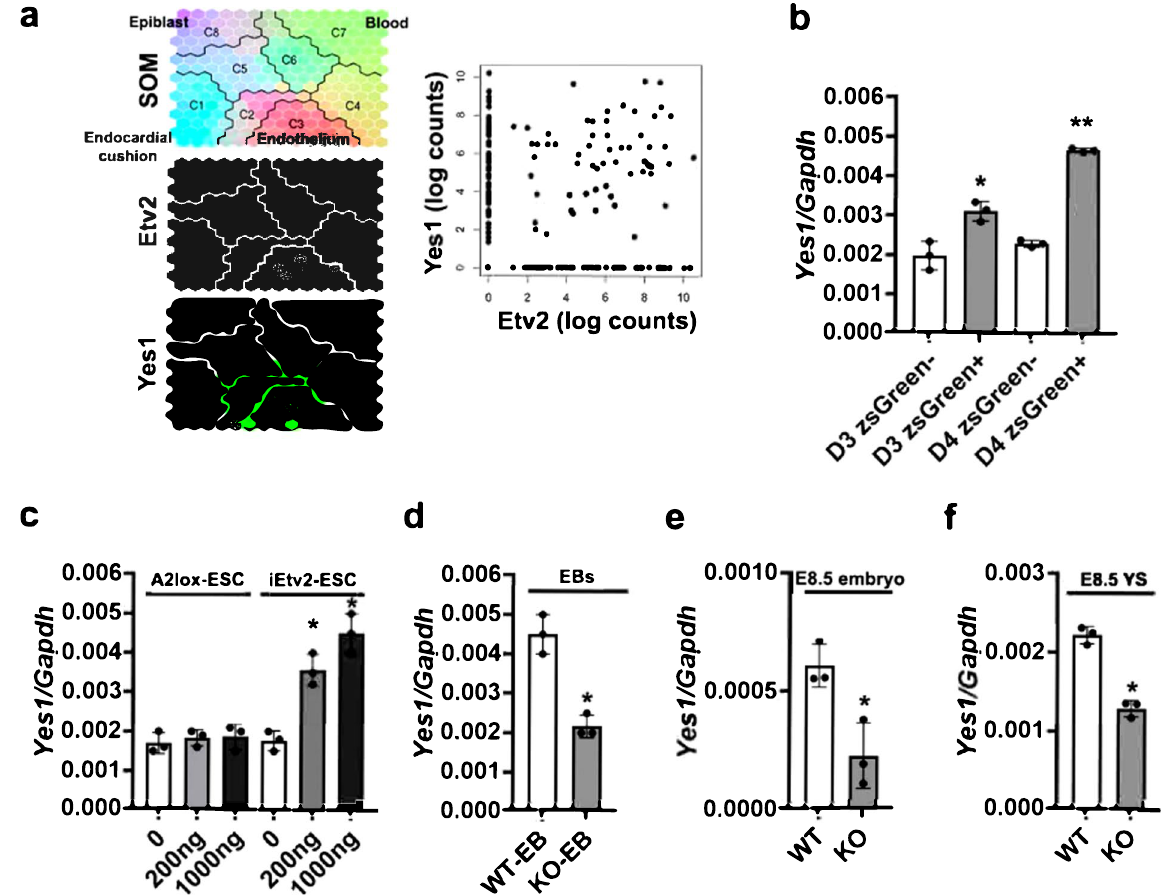
Figure 4. Yes1 is co-expressed with Etv2 during embryogenesis. ( a ) Left panel: Dpath analysis of single cell RNAseq data 10,27 from Etv2 - EYFP embryos 5 at E7.25, E7.75, and E8.25. Note both Yes1 and Etv2 were highly expressed in the endothelial lineage. Right panel: Visualization of Yes1 and Etv2 expression within each cell population. Note that high Etv2 expression is positively correlated with high Yes1 expression. ( b ) qPCR analysis for Yes1 transcripts from zsGreen − and zsGreen + sorted cells using the Etv2 - zsGreen1-DR ES/EB system 11 at D3 and D4 of differentiation. Note a significant enrichment of Yes1 in the zsGreen + cells relative to the zsGreen − cells. ( c ) qPCR analysis for Yes1 transcripts from –Dox and increasing concentrations of Dox using RNA isolated from A2Lox and iHA-Etv2 ES/EB system 8 . Note a significant enrichment of Yes1 in the induced EBs relative to A2Lox EBs. ( d ) qPCR analysis for Yes1 transcripts from wildtype (WT) and Etv2 null (KO) ES/ EBs. The expression levels of Yes1 were reduced in the Etv2 null EBs relative to WT EBs. ( e , f ) qPCR analysis for Yes1 transcripts from wildtype (WT) and Etv2 null (KO) embryos and yolk sacs (YS) at E8.5. The levels of Yes1 were reduced in the Etv2 null embryos and Etv2 null yolk sacs compared to controls. Data are presented as mean ± SEM (n = 3 replicates; ** p < 0.01; * p <